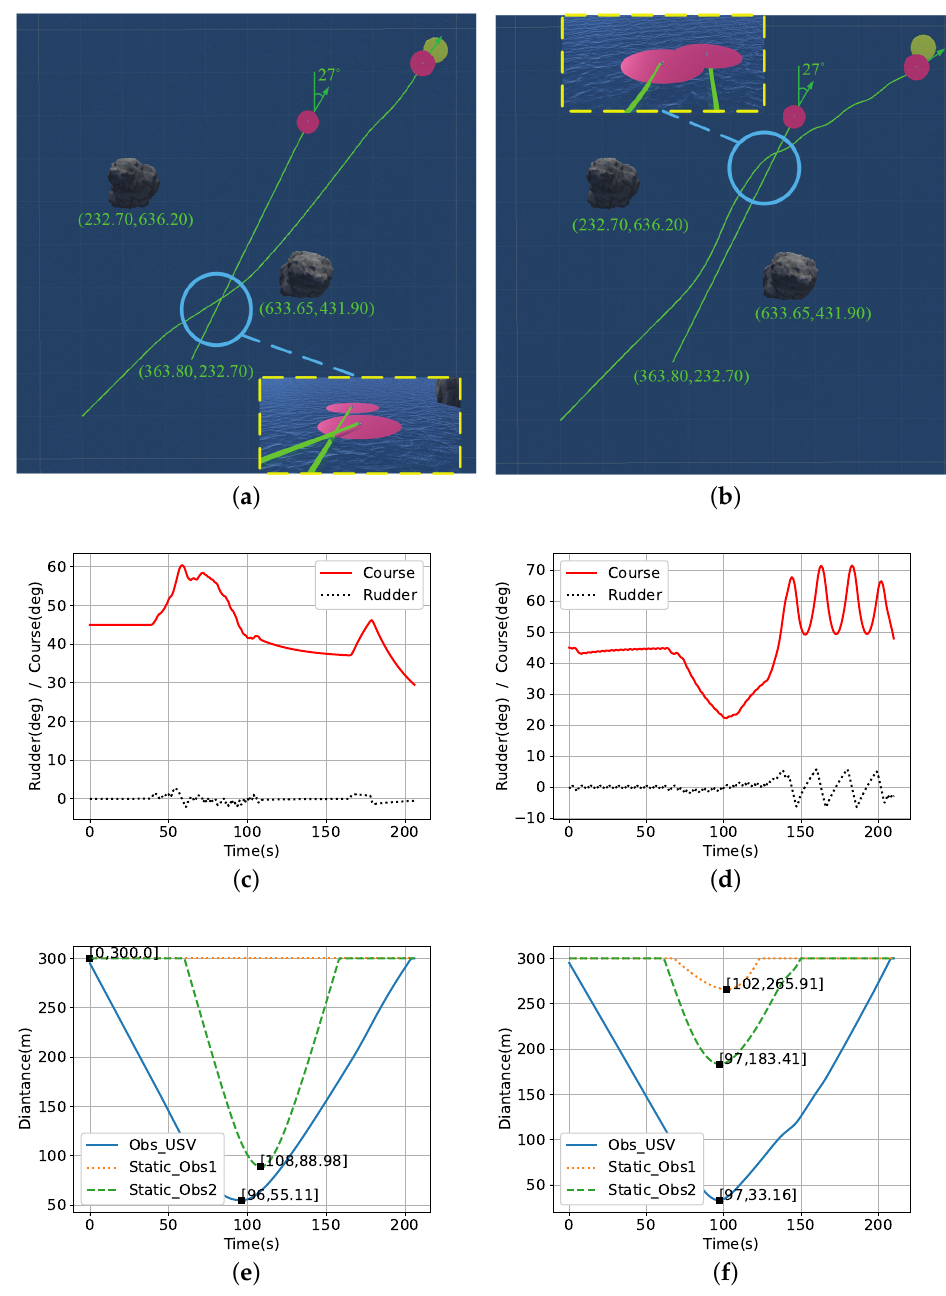
Figure 14. Encounter situation 4. ( a ) Path planned by DRLCA; ( b ) Path planned by DQN; ( c ) Course and rudder for DRLCA; ( d ) Course and rudder for DQN; ( e ) Distance for DRLCA; ( f ) Distance for